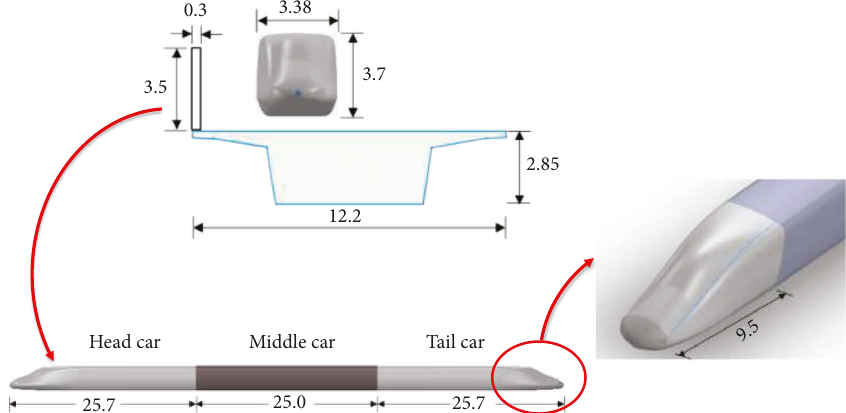
Figure 2: Dimensions of vehicle models and bridge models (unit: m).